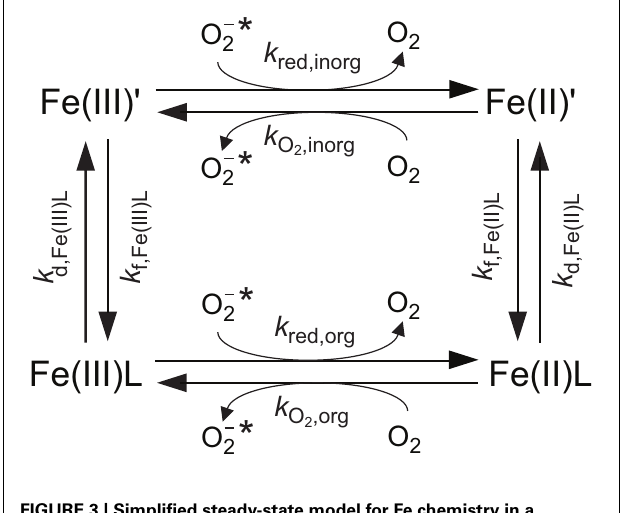
FIGURE 3 | Simplified steady-state model for Fe chemistry in a spatially homogeneous system containing O −∗ that forms a 1:1 complex with Fe, showing relevant rate